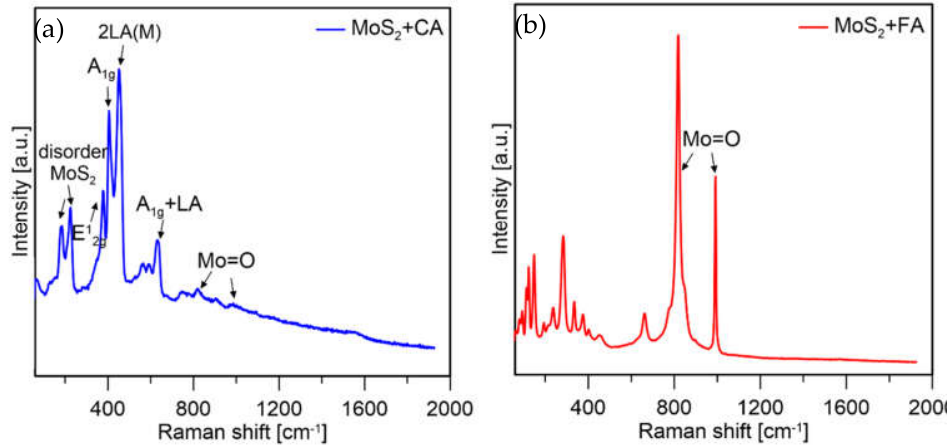
At the beginning of the measurement for both samples, the same conditions were